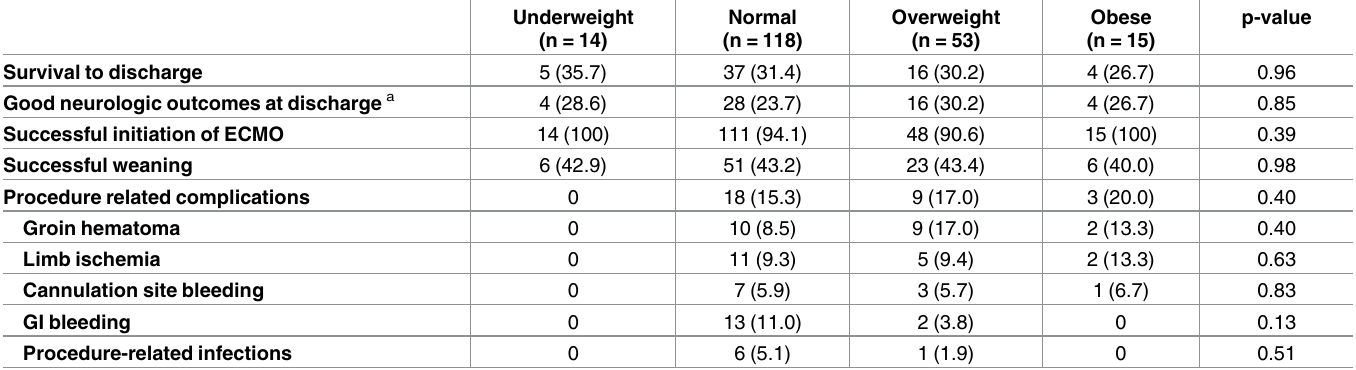
Table 3. Extracorporeal cardiopulmonary resuscitation